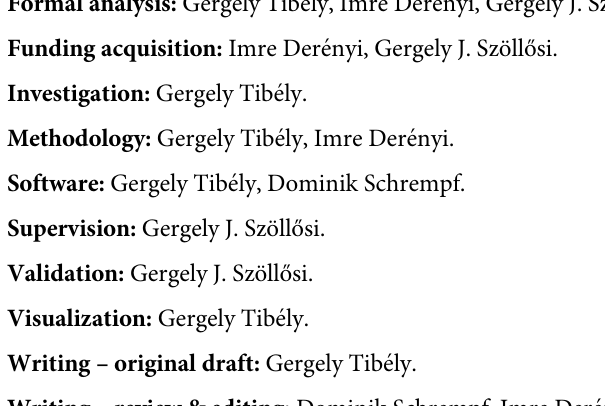
aligned. Fig G: The effect of the error rate on the estimated mutation rate . In 500 replicate experiments we introduced a “driver” mutation that increases 1 − δ by 30%. The large purple point indicates the parameter values used to simulate the data, gray circles are inferences for data without driver mutations from Fig 3, and purple datapoints are inferences for data includ- ing drivers. A small, but systematic increase is apparent in the inferred values of both the mutation rate and the death-to-birth ratio compared to “wild type” values resulting from the subtree with an increased death-to-birth ratio driver